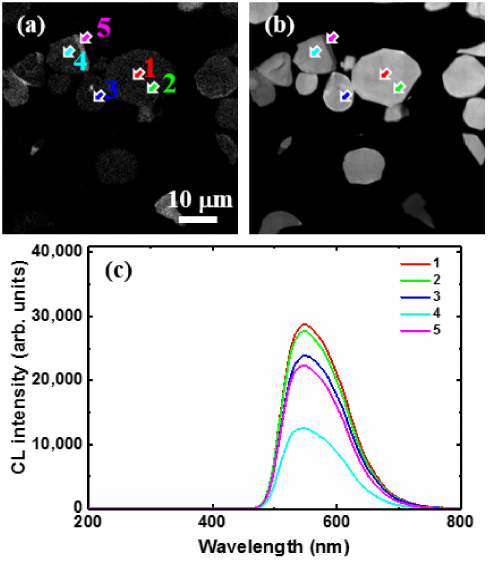
Figure 6. Cross-sectional CL images taken at 330 nm ( a ); and 540 nm ( b ) for untreated YAG:Ce 3+ ; ( c ) Local CL spectra taken on locations indicated by arrows in the